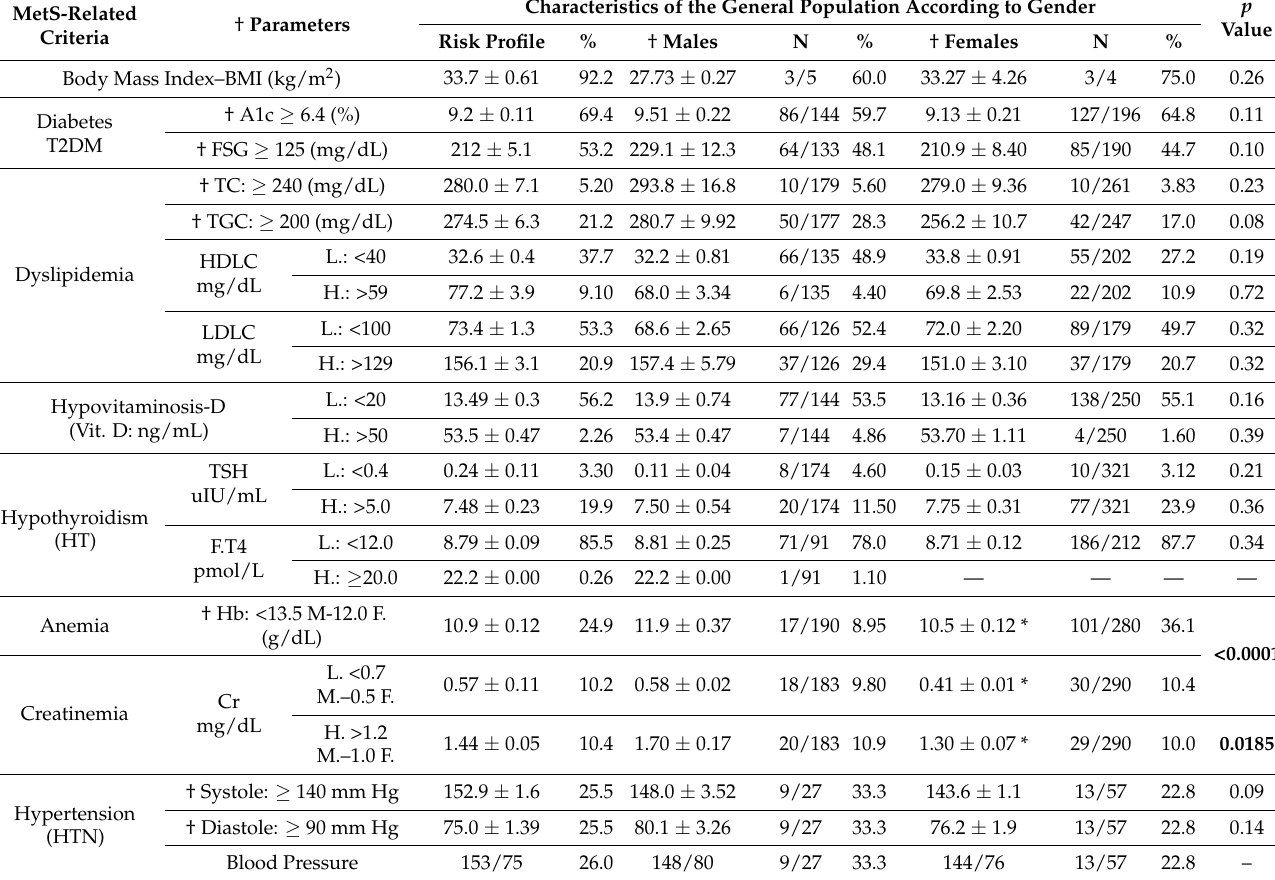
Table 1. Characteristics of the risky MetS according to gender in the general population. Metabolic profiles include: A1C and FSG for T2DM, TC, TGC, HDLC, and LDLC for dyslipidemia, Vit. D for hypovitaminosis-D, TSH and F. T4 for hypothyroidism, Hb diagnosed anemia and Cr for renal function, in addition to the blood pressure parameters of systole and diastole. BMI was also detected. † denotes risky levels: L; low, H; high. M; male, and F; female. All data were presented as mean ± SEM. Differences between overweight and obese groups were considered significant at * p < 0.05–NS denotes a nonsignificant